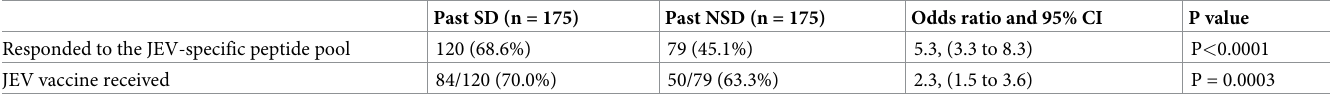
Table 2. Severity of past severe disease in those who responded to the JEV specific peptides and in those who received the JEV